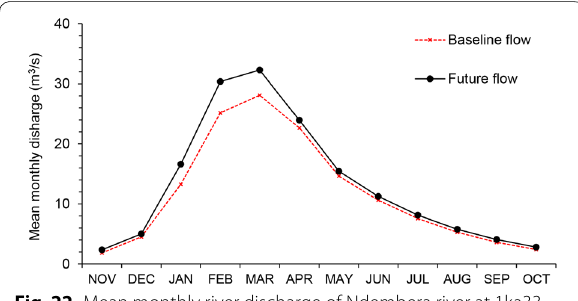
Fig. 22 Mean monthly river discharge of Ndembera river at 1ka33 under the near-term climate scenario compared to the baseline